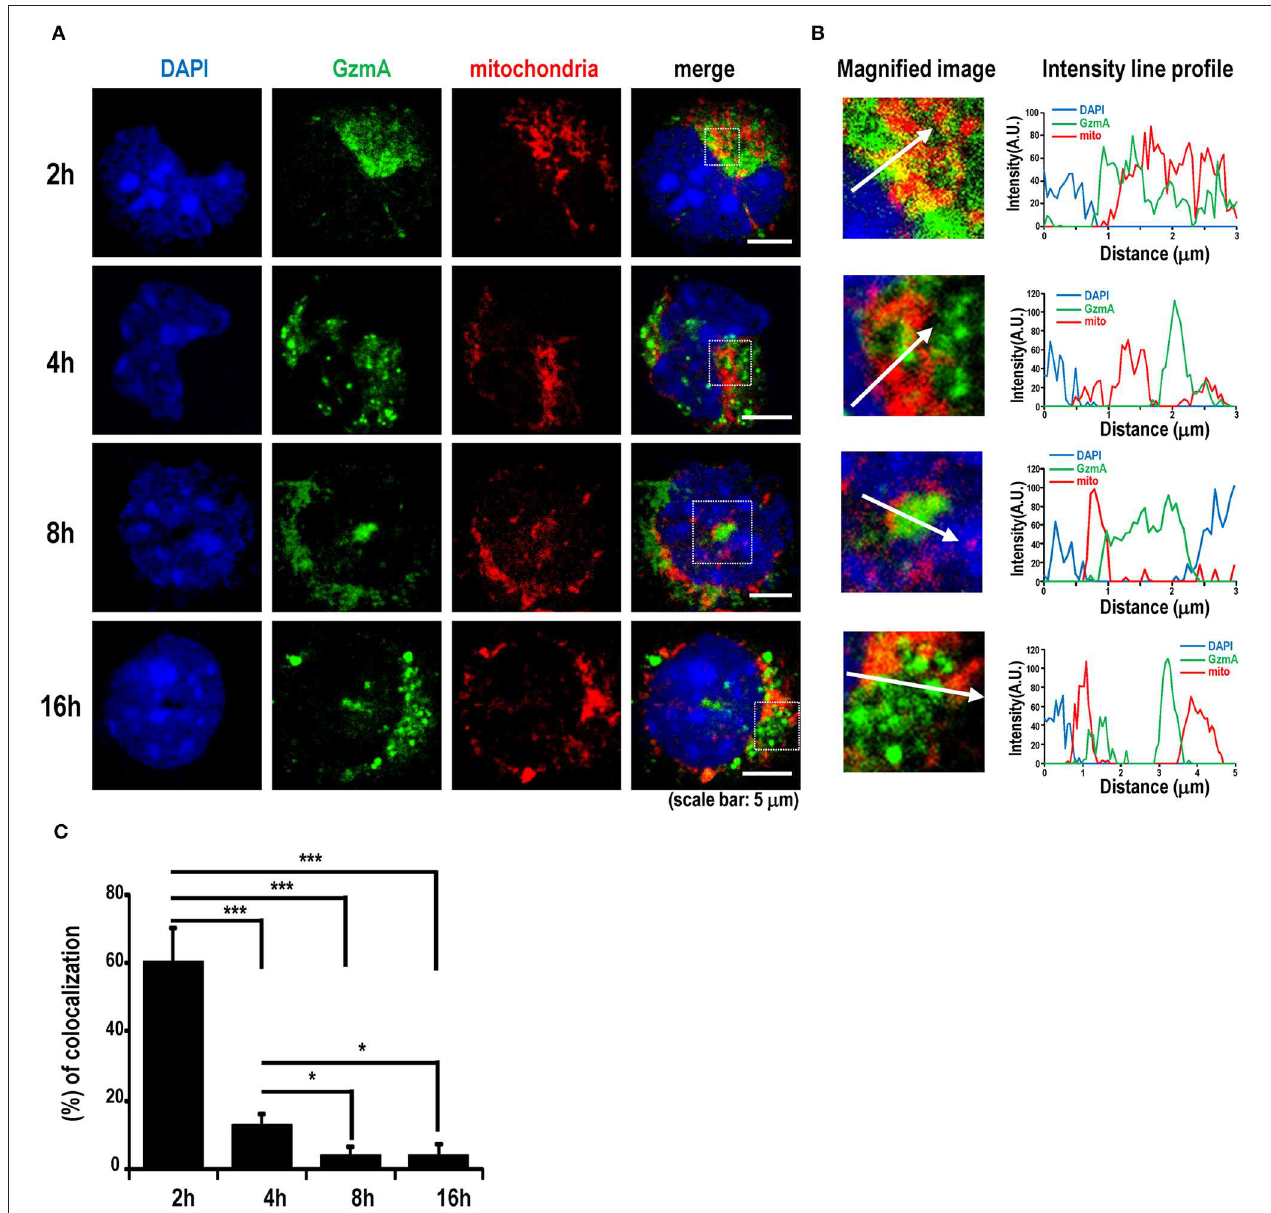
FIGURE 6 | GzmA binds to mitochondria. (A) Representative images showing localization of GzmA in pDCs. Sorted pDCs incubated with Alexa488-labeled GzmA (green) were harvested at the indicated time points and stained with mito-tracker (red) to detect the co-localization of GzmA and mitochondria. Scale bars, 5 µ m. (B,C) Intensity line profiles from magnified images were assessed. Line scans represent variation in red and green fluorescence intensity along the line denoted by an arrow and then the colocalization was quantified (mean ± SEM, n = 10). * p < 0.05; *** p < 0.001 (one-way ANOVA test with Tukey’s post-hoc test).